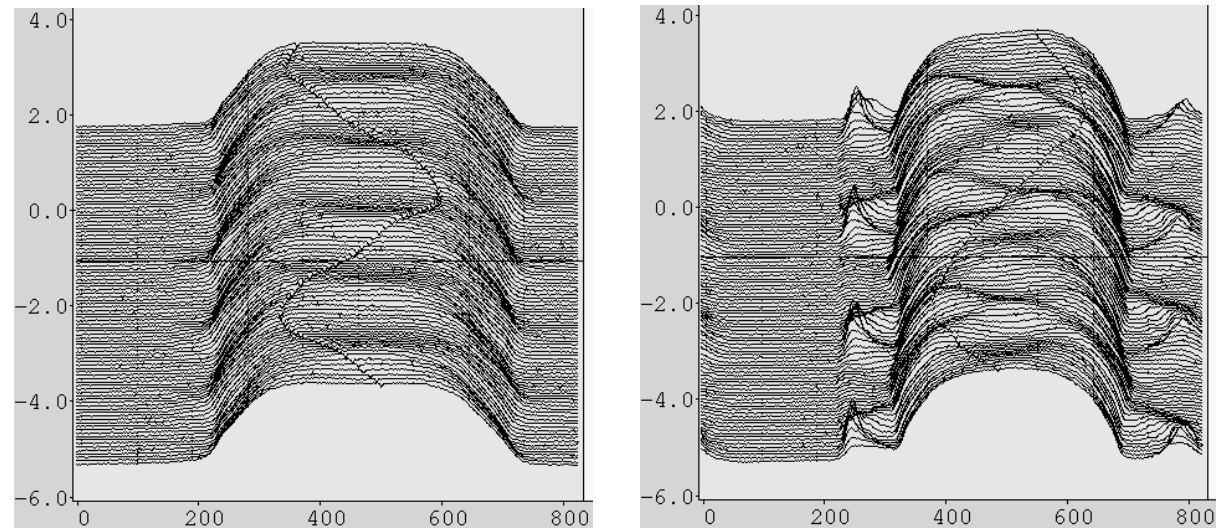
FIG. 14. Mountain-range plots of line density. Left: start at 162 ms, one trace each 25 turns, span 4.0 ms. Right: start at 202 ms, one trace each 20 turns, span 3.1 ms. Abscissa in nanoseconds. 5.5 3 10 12 protons. Dual harmonic with V 2 (cid:3) V 1 (cid:1) 0.5